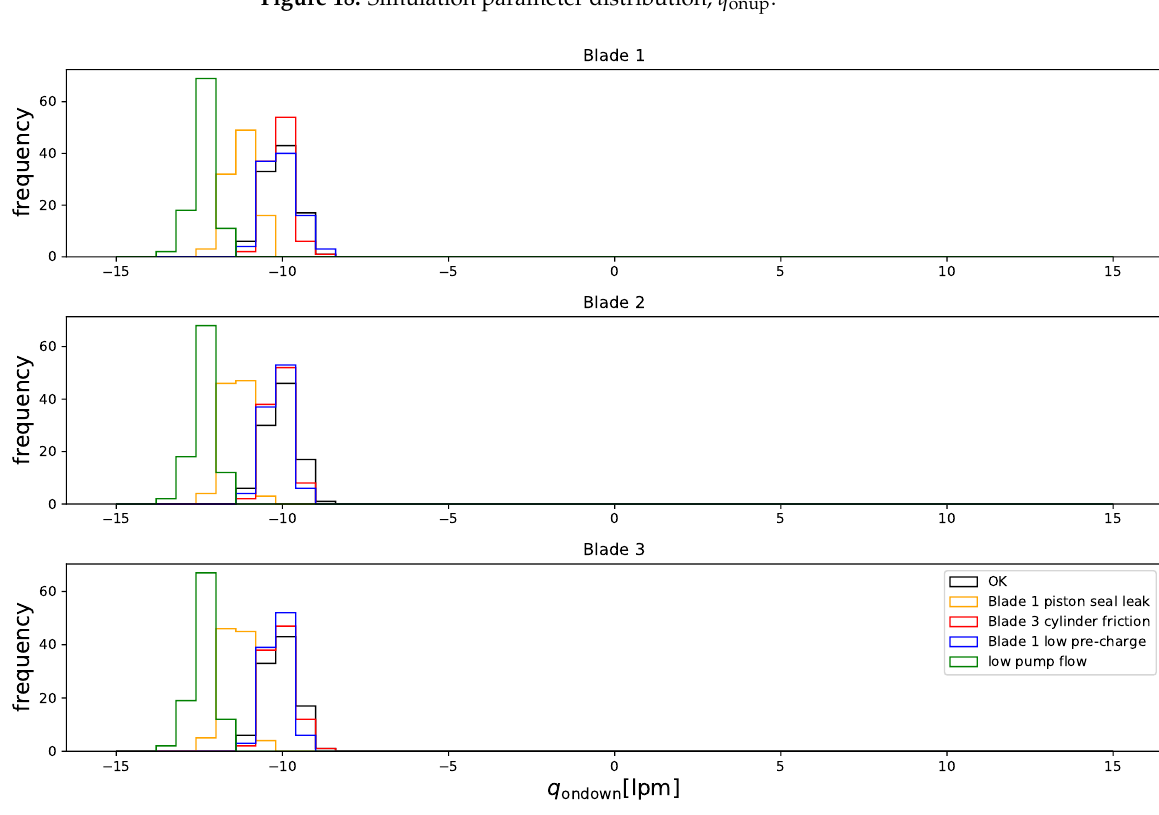
Figure 19. Simulation parameter distribution, q ondown